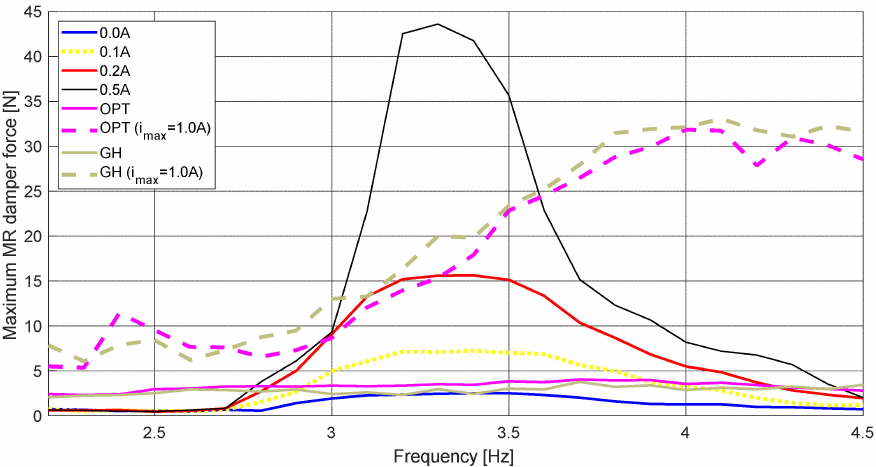
Figure 12. The maximum MR damper force frequency characteristics: passive system vs. OPT for F nom = 12.5 N vs. GH for F nom = 12.5 N.